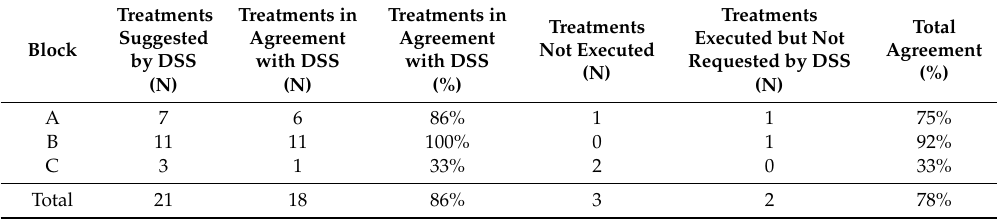
Table 3. Indication of the treatments suggested by DSS and those realized in agreement or not for single blocks and total. The total agreement was obtained by considering the treatments that were in agreement with DSS compared to all the executed treatments. N is the number of treatments; % is the